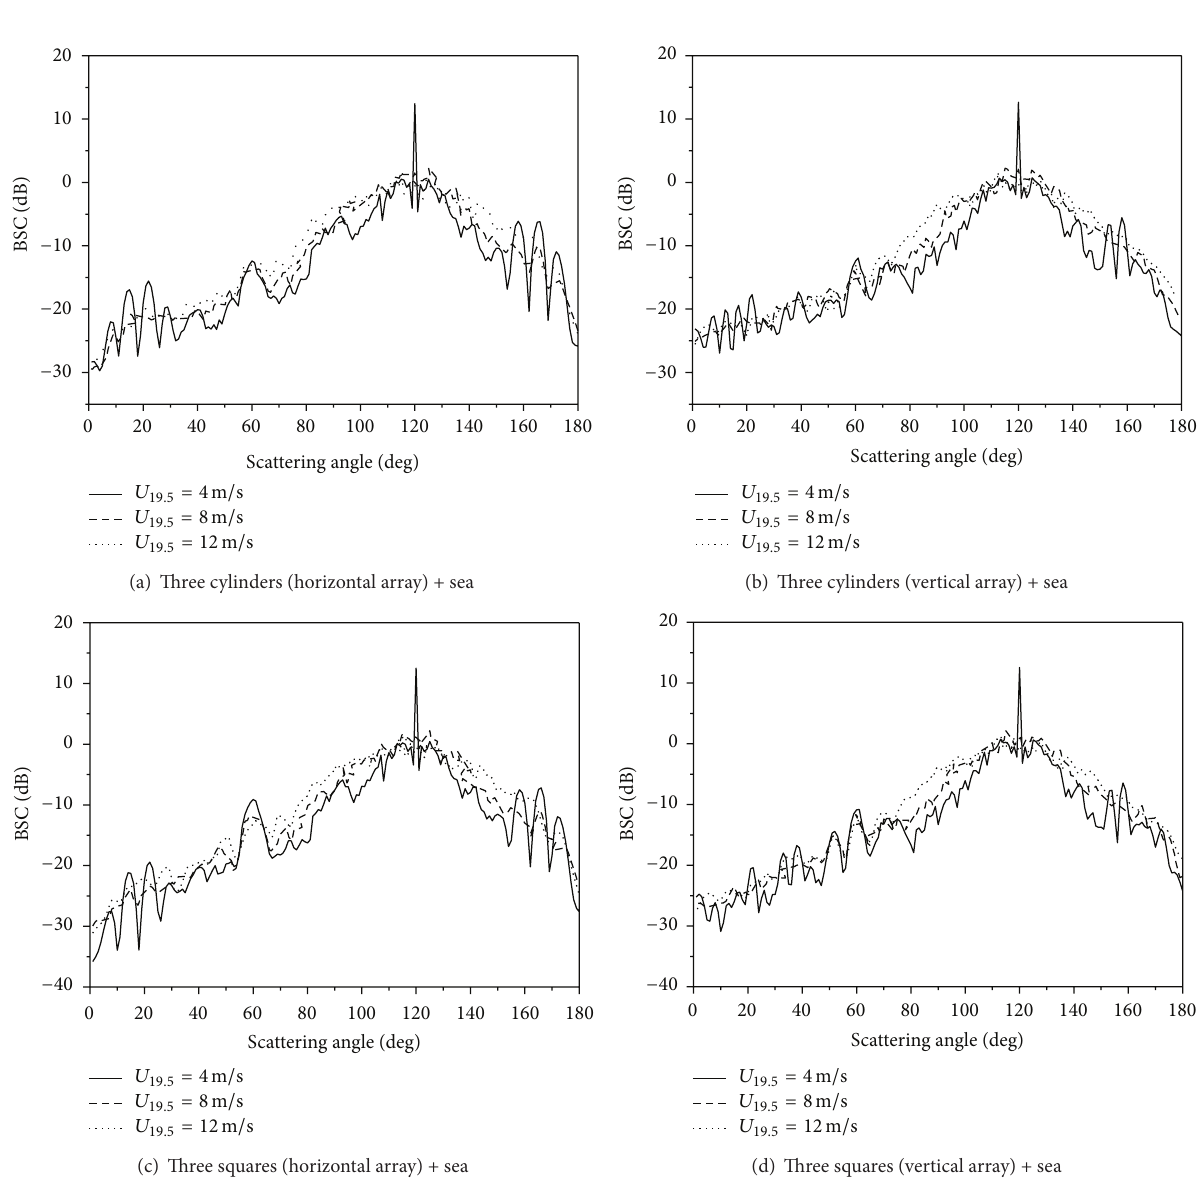
Figure 6: BSC of three objects over the rough sea surface of different 𝑈 19.5